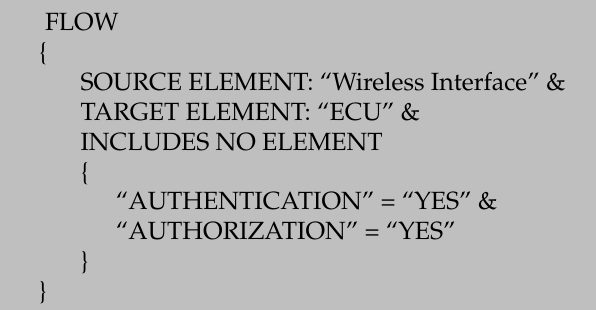
Figure 6. An example for a flow